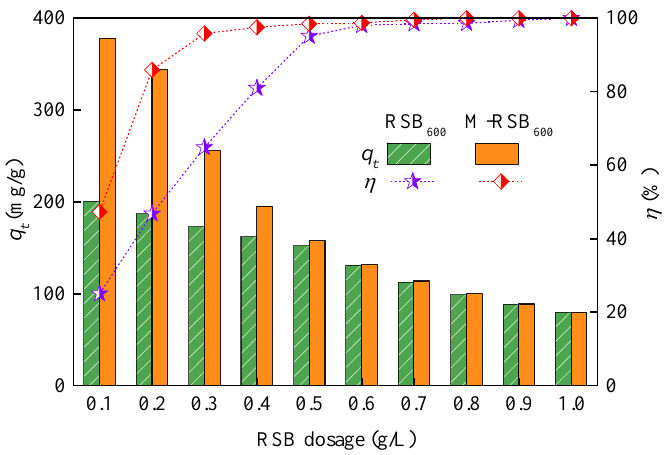
Figure 6. The adsorption performance under different RSB dosages.